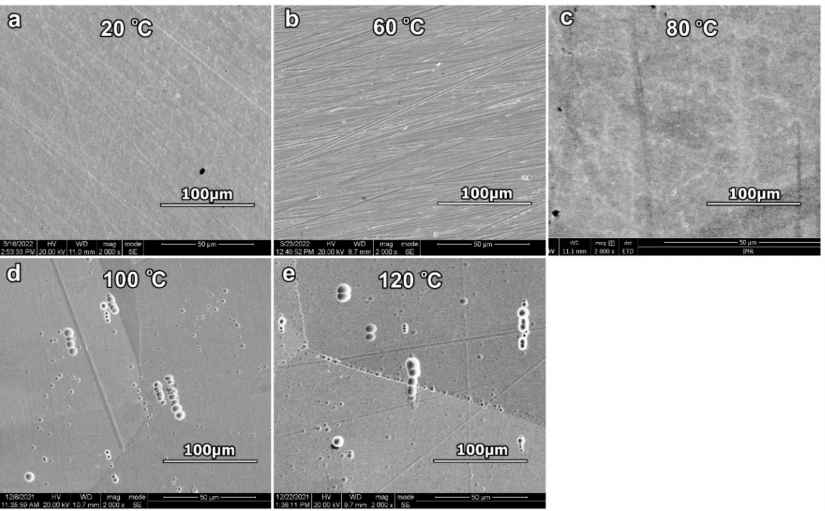
Figure 4. Corrosion morphologies of SiN stainless steel after immersion in nitric acid liquid phase at